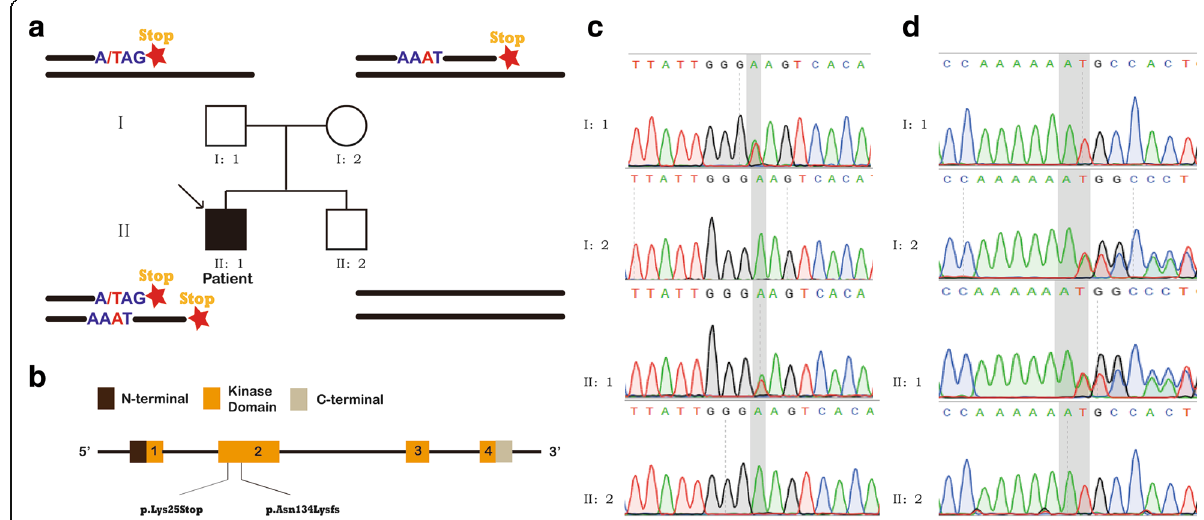
Fig. 2 Genogram, mutation patterns and electropherograms of the index patient. a The genogram showed an isolated patient. Roman numerals indicate generations and Arabic numbers indicate individuals. Squares=males, circles=females. Affected individuals are denoted by solid symbols and unaffected individuals are denoted by open symbols. The index patient is indicated by an arrow. The two mutations were inherited from father and mother respectively. b The structure of BCHE gene. This novel mutation is within exon 2. c The electropherograms of the mutation c.73A>T of exon 2. The shadowed column was mutation point. d The electropherograms of the mutation c.401_402insA of exon 2. The shadowed column was insertion